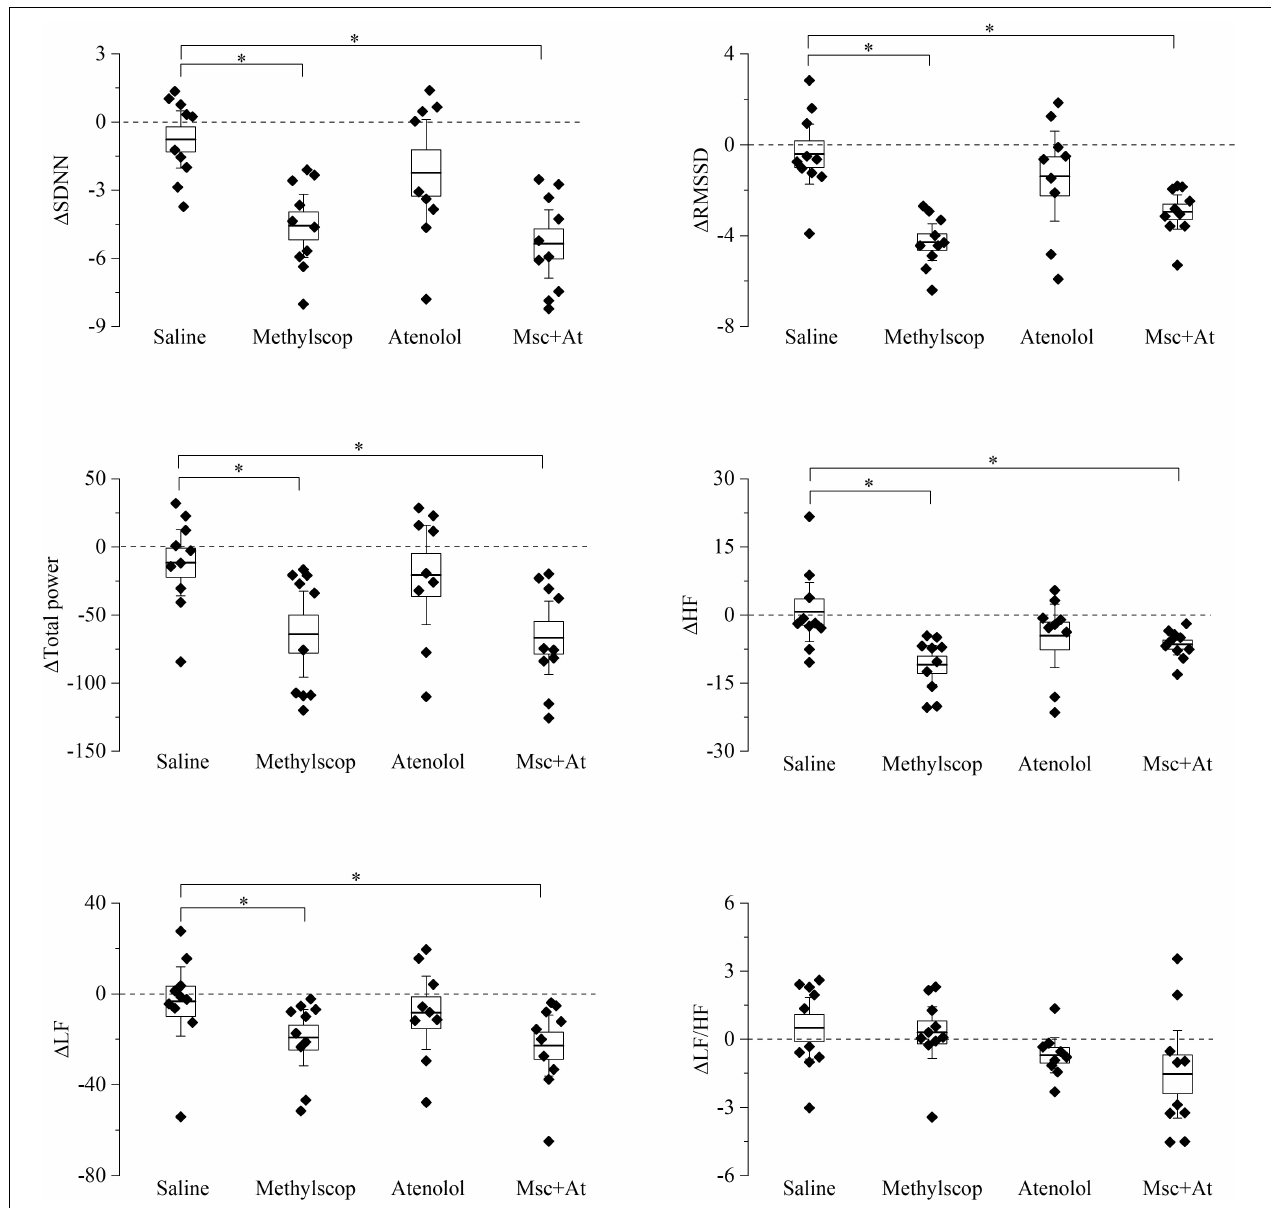
FIGURE 3 | Heart rate variability parameters response to pharmacological autonomic blockade in 4-month-old mice. Changes in the heart rate variability parameters calculated from ECG traces recorded from 60 to 120 min after i.p. injection of vehicle (saline) and autonomic modulator drugs (Methylscopolamine, Atenolol, Methylscopolamine + Atenolol) in 4-month-old freely moving mice ( n = 10). The dotted line (reference level) indicates mean basal HRV indexes recorded 60 min before drug administration. In the box chart, middle line indicates the mean value, delimiting lines of the box represent SEM and whiskers are confidence intervals at 95%. ∗ p < 0.05, one-way ANOVA with repeated measures followed by Fisher’s LSD post hoc